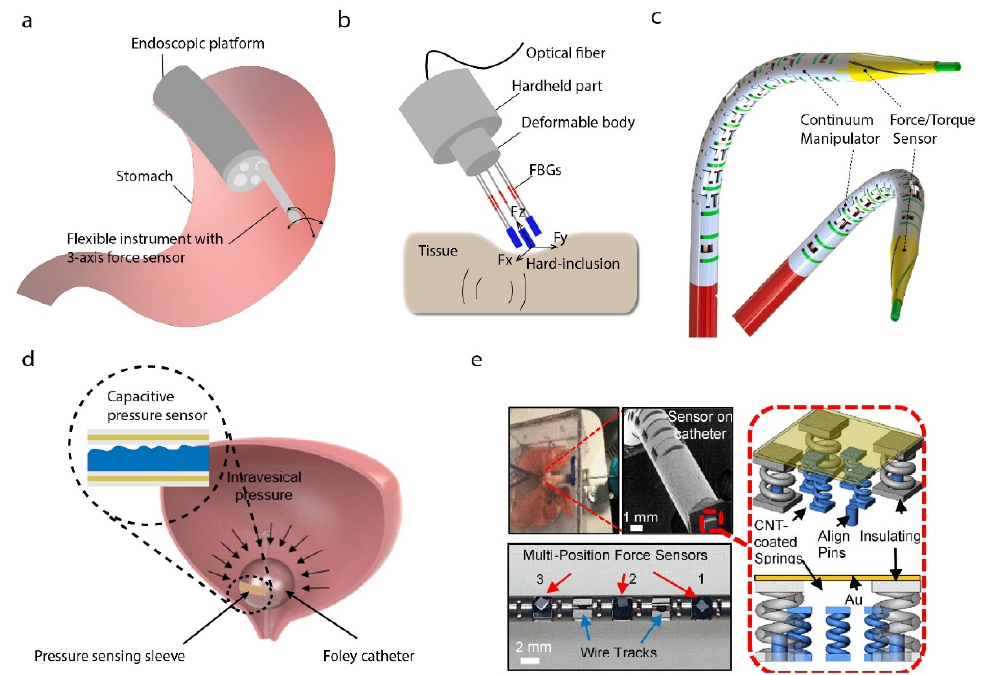
Figure 4. Probes for in vivo force sensing. ( a ) Flexible medical instrument for 3-axis force sensing [43]. ( b ) An elastic element with an orthogonal beam structure for end-effector 3D force decomposing [44]. ( c ) A spiral FBG force sensors-based method to measure the force and torque applied at the tip of the probe. Reprinted with permission from Ref. [45]. Copyright 2020, Elsevier. ( d ) A